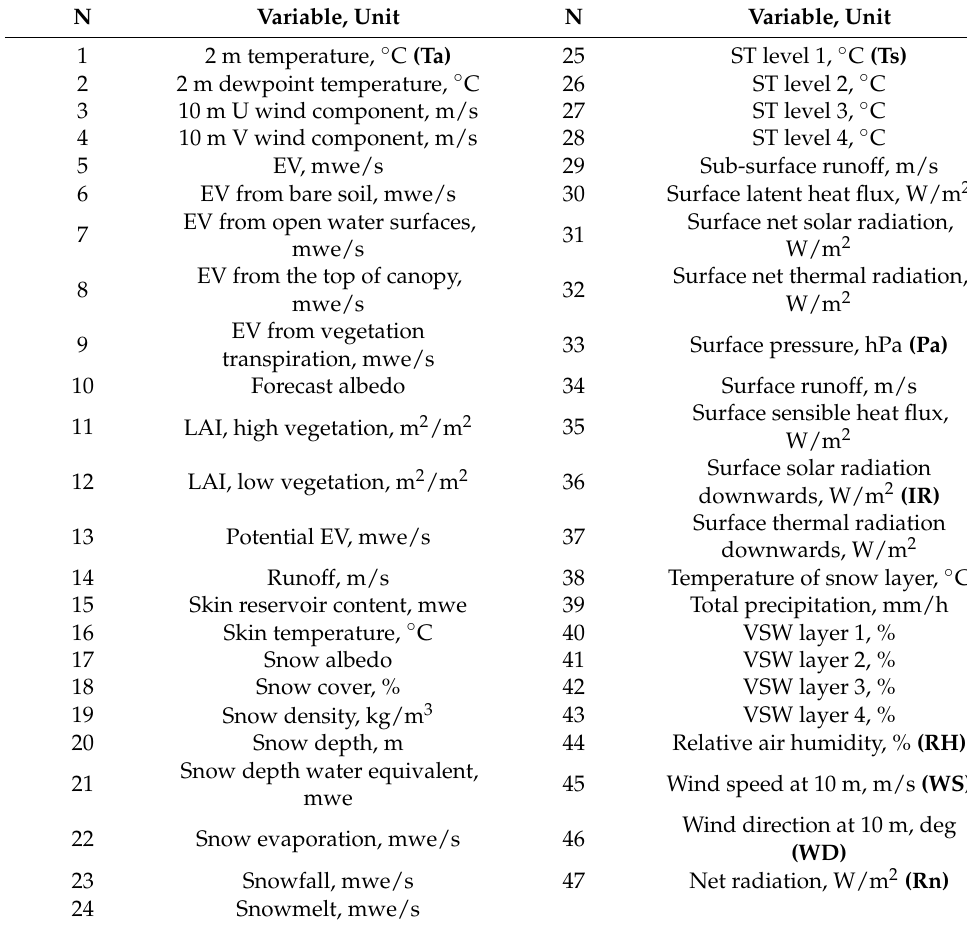
Table 2. List of meteorological variables from ERA5-Land reanalysis used for gap-filling. Correspond- ing target variables from Table 1 are indicated in bold and in